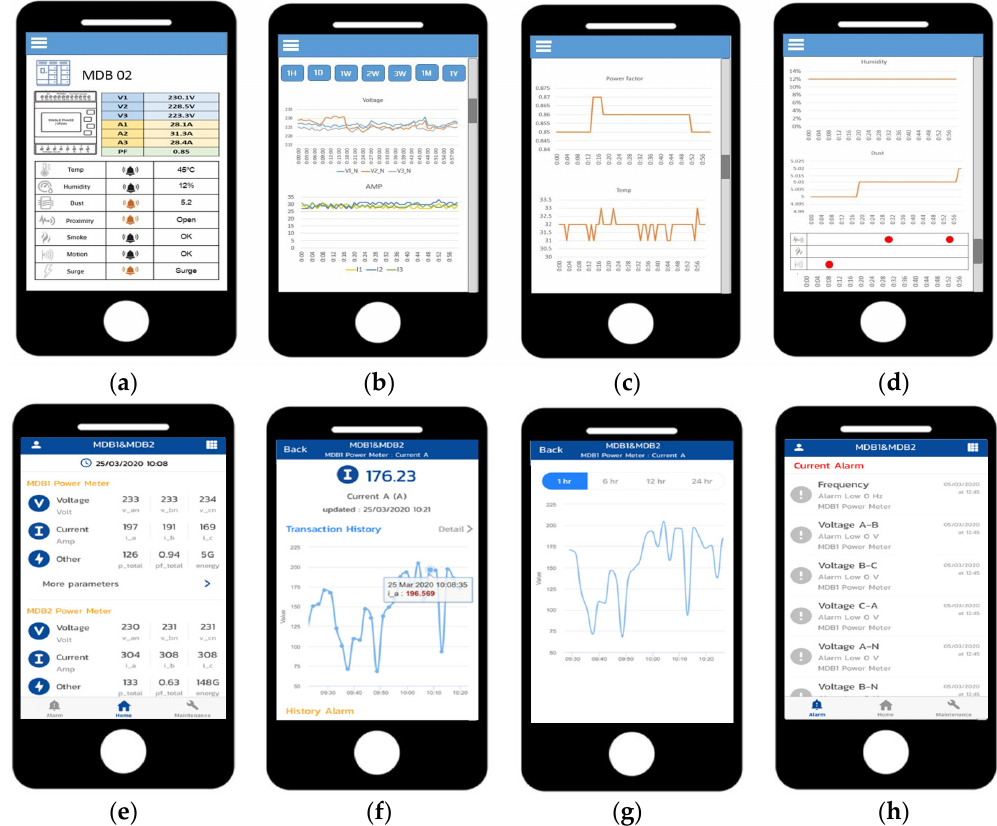
Figure 5. Display of the results via a smartphone device to control an electric switchboard, consisting of ( a ) various system notification settings, ( b ) the amount of electricity consumption, ( c ) the current electric power and temperature, ( d ) the amount of humidity inside the switchboard, ( e ) power quality and related parameters, ( f ) power quality and parameters in graph model, ( g ) graphs reporting the past 24 h of electricity consumption, and ( h ) electrical fault warning area in the switchboard.